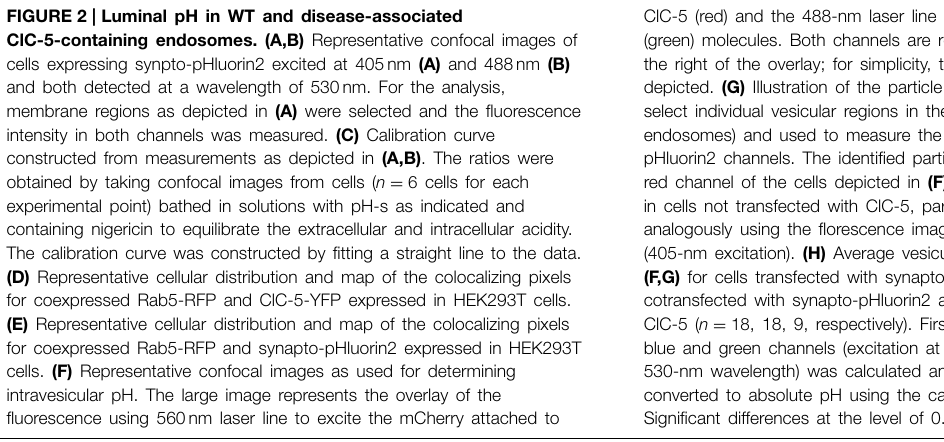
ClC-5 (red) and the 488-nm laser line to excite the synapto-pHluorin2 (green) molecules. Both channels are represented as small sub-images at the right of the overlay; for simplicity, the 405-nm channel was not depicted. (G) Illustration of the particle identification procedure used to select individual vesicular regions in the red channel (ClC-5-containing endosomes) and used to measure the fluorescence intensities in both pHluorin2 channels. The identified particles are overlaid as circles on the red channel of the cells depicted in (F) . For measuring of endosomal pH in cells not transfected with ClC-5, particle detection was performed analogously using the florescence images taken in the blue channel (405-nm excitation). (H) Average vesicular pH determined as depicted in (F,G) for cells transfected with synapto-pHluorin2 only (mock, n = 7 ) or cotransfected with synapto-pHluorin2 and either WT, G212A or E267A ClC-5 ( n = 18 , 18, 9, respectively). First, the ratio of the intensities of the blue and green channels (excitation at 405 and 488nm, both detected at 530-nm wavelength) was calculated and this ratio was subsequently converted to absolute pH using the calibration curve depicted in (C) . Significant differences at the level of 0.05 are indicated as